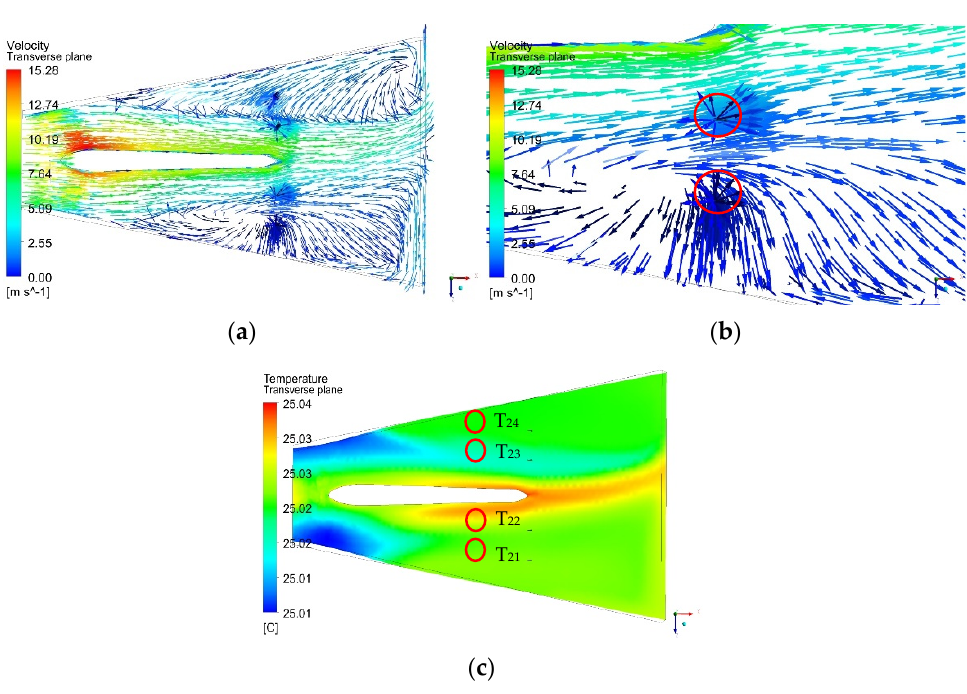
Figure 16. Manifold´s in the draft tube, ( a ) Recirculation flow (normalized symbols), ( b ) Recirculation flow in manifolds, left section “zoom” (normalized symbols) ( c ) Temperature contour.